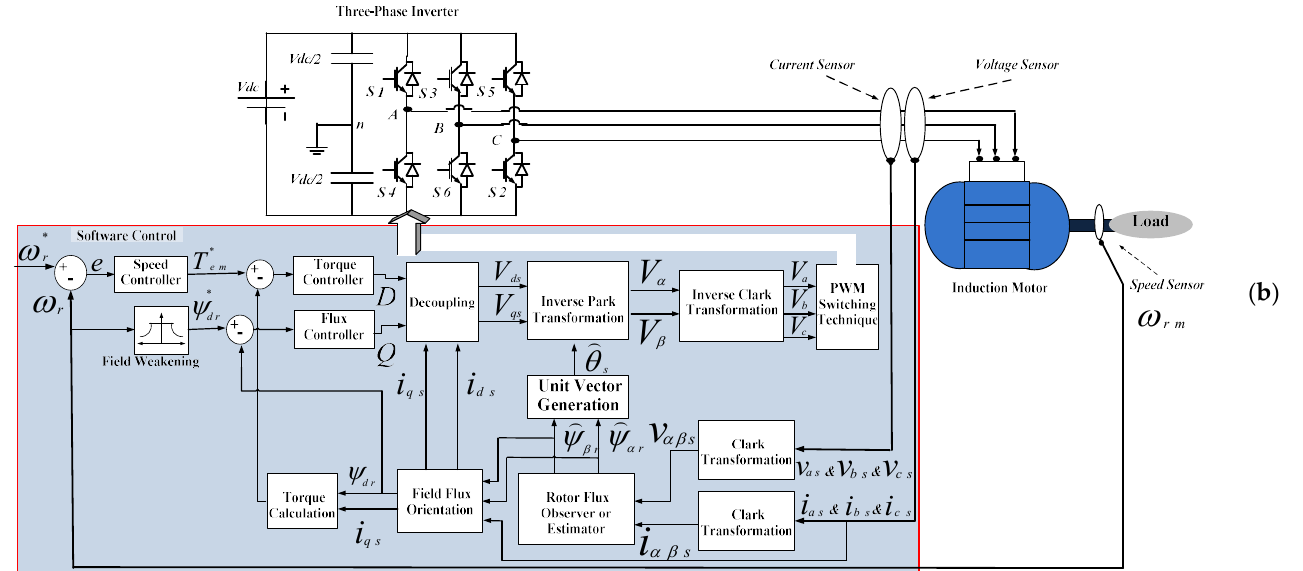
Figure 5. ( a ). Block diagram of DFOC via flux sensor for IM drive. ( b ). Block diagram of DFOC via rotor flux estimator or observer for IM drive.